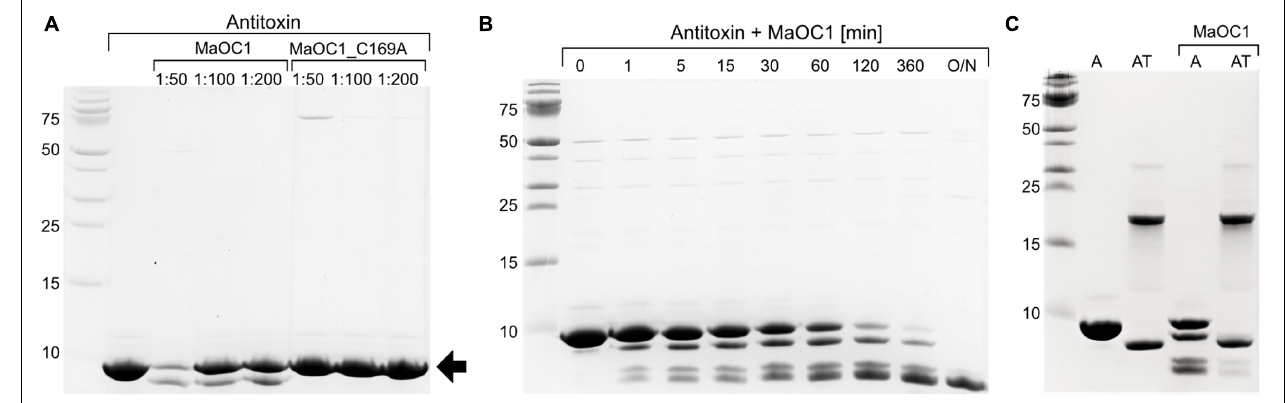
FIGURE 6 | Proteolytic cleavage of the antitoxin or the TA complex with the orthocaspase MaOC1. (A) The 1067 antitoxin was incubated in the presence of a wild-type MaOC1 or its proteolytically inactive variant MaOC1_C169A in the mass ratios given for 2 h at room temperature. The reaction mixtures were then electrophoresed on a 16% Tris-tricine gel and stained with Coommasie Brilliant Blue. The arrow represents the expected size of the full-length C-terminally tagged antitoxin (9.5 kDa). (B) Reactions containing the antitoxin with MaOC1 (ratio 1:50) were stopped at various times, loaded onto the 16% Tris-tricine gel and stained with Coommasie Brilliant Blue after electrophoresis. (C) The antitoxin (A) or the complex (AT) were incubated for 1 h in the absence or presence of MaOC1 orthocaspase (mass ratio 1:100 protein:protease) and applied in duplicates to the 16% Tris-tricine gel. After electrophoresis, the gel was stained with Coommasie Brilliant Blue. All cleavage assays were performed in 20 mM HEPES, pH 7.4, 150 mM NaCl and at room